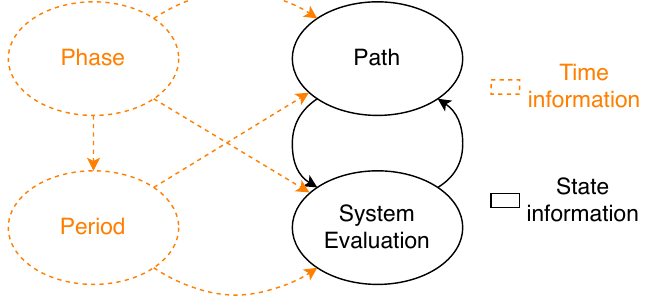
Figure 7. Modules in the general model. The module system evaluation decides whether the system has failed, the module path models the transmission of frames, and the modules phase and period manage the pass of time in the